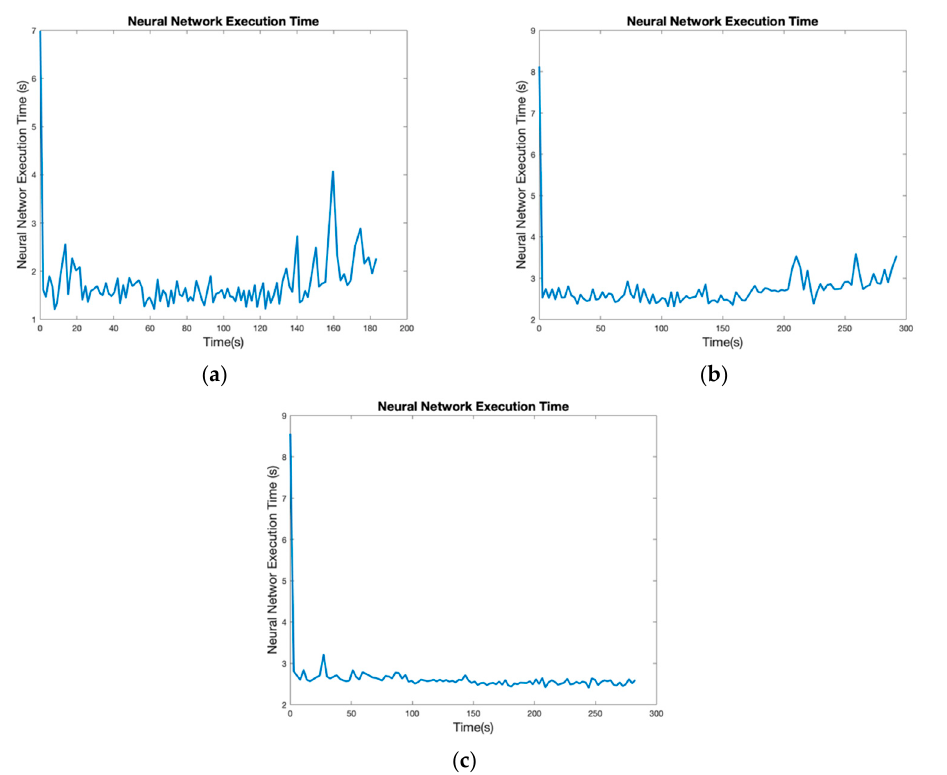
Figure 19. Other Semantic Segmentation Network CPU execution times: ( a ) ResNet-18; ( b ) Figure Segnet(vgg19); ( c ) Unet.